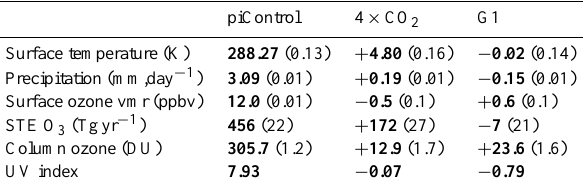
Table 2. Global annual mean quantities. For piControl and corre- sponding differences under 4 × CO 2 and G1 (highlighted in bold). The clear-sky, unpolluted UV index at noon is calculated using the formula by Madronich (2007), including only changes by column ozone and by the solar irradiance reduction. Standard deviations for the annual mean data are given in brackets, with the exception of the mean UVI indices, which were calculated from climatological ozone fields without inter-annual